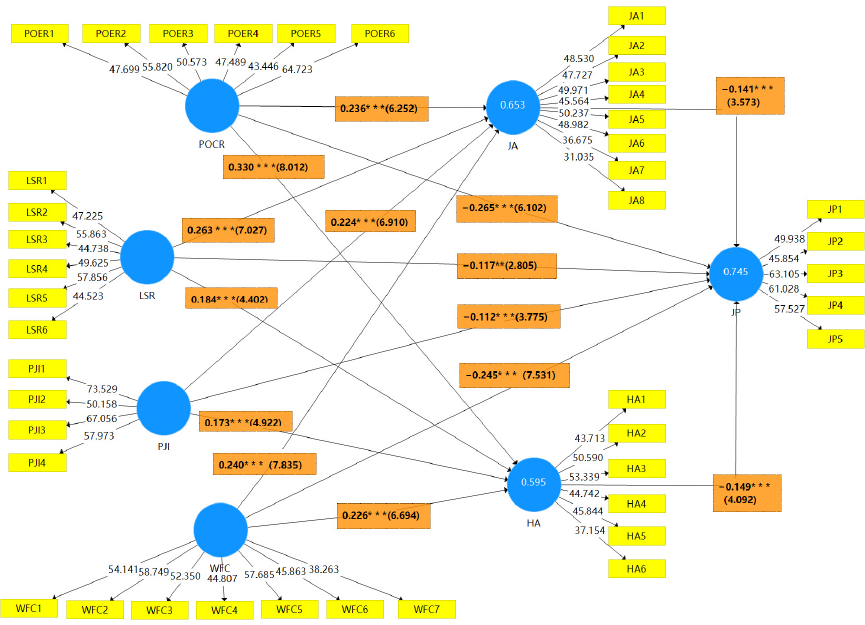
Figure 2. Graphical representation of the structural model. Note: ** p < 0.01, *** p < 0.001. The results of the analysis of the above models showed that POCR (H1a, H1b) had a positive direct effect on JA and HA ( β = 0.236, p < 0.001; β = 0.330, p < 0.001). However, H1c showed that POCR had a negative direct e ff ect on JP ( β = − 0.265, p < 0.001). This implies that high POCR leads to low employee performance. The results of H2a and H2b show that LSR has a positive and significant direct effect on JA and HA ( β = 0.263, p < 0.001; β = 0.184, p < 0.001). However, the results of H2c showed that LSR had a negative direct effect on JP ( β = − 0.117, p < 0.01). This implies that the higher the LSR, the lower the job performance. The results of H3a and H3b show that PJI has a positive direct effect on JA and HA ( β = 0.224, p < 0.001; β = 0.173, p < 0. 001). Furthermore, H3c demonstrates that PJI has a negative effect on employees’ JP ( β = − 0.112, p < 0.001). These findings imply that high PJI results in poor employee job performance. The results of H4a and H4b show that WFC has a positive direct effect on JA and HA ( β = 0.240, p < 0. 001; β = 0.226, p < 0.001), while H4c demonstrates that WFC negatively a ff ects employees’ JP ( β = − 0.245, p < 0.001). This means that as the WFC increases, job performance decreases. It is assumed that H5 and H6 (JA and HA) have a signi fi cant negative e ff ect on employees’ JP ( β = − 0.141, p < 0.001; β = − 0.149, p < 0.001), as shown in Table 8 of the specific data results. Table 8. Hypotheses testing—direct effects. Hypothesis